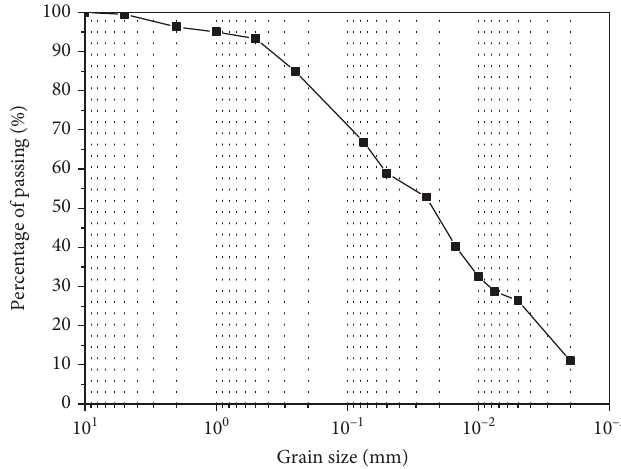
Figure 1: Cumulative curve of soil particle-size distribution.